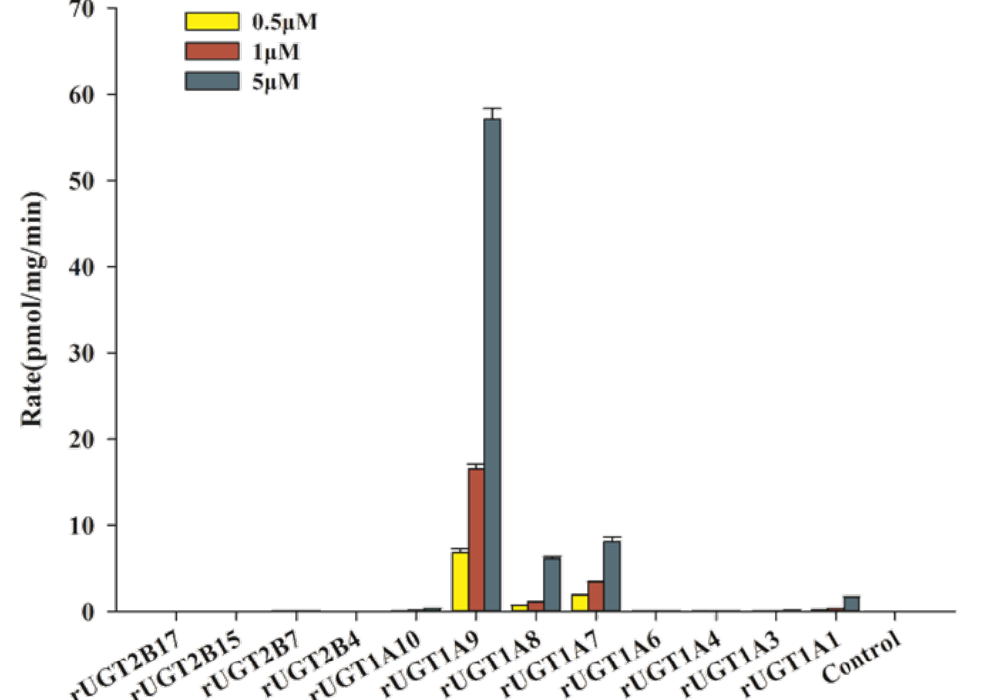
Figure 4. Glucuronidation of GL-V9 by twelve recombinant human UGTs. Three concentrations of GL-V9 were selected to incubate with 12 commercially available UGTs (0.05 mg/mL) at 37 °C for 1 h. Glucuronides of GL-V9 in incubation system were quantified through UPLC-MS/MS. The formation rates were calculated and described as pmol/min/mg protein. Each bar is the average of three detection values, and the error bars are standard deviations of the mean (n = 3).